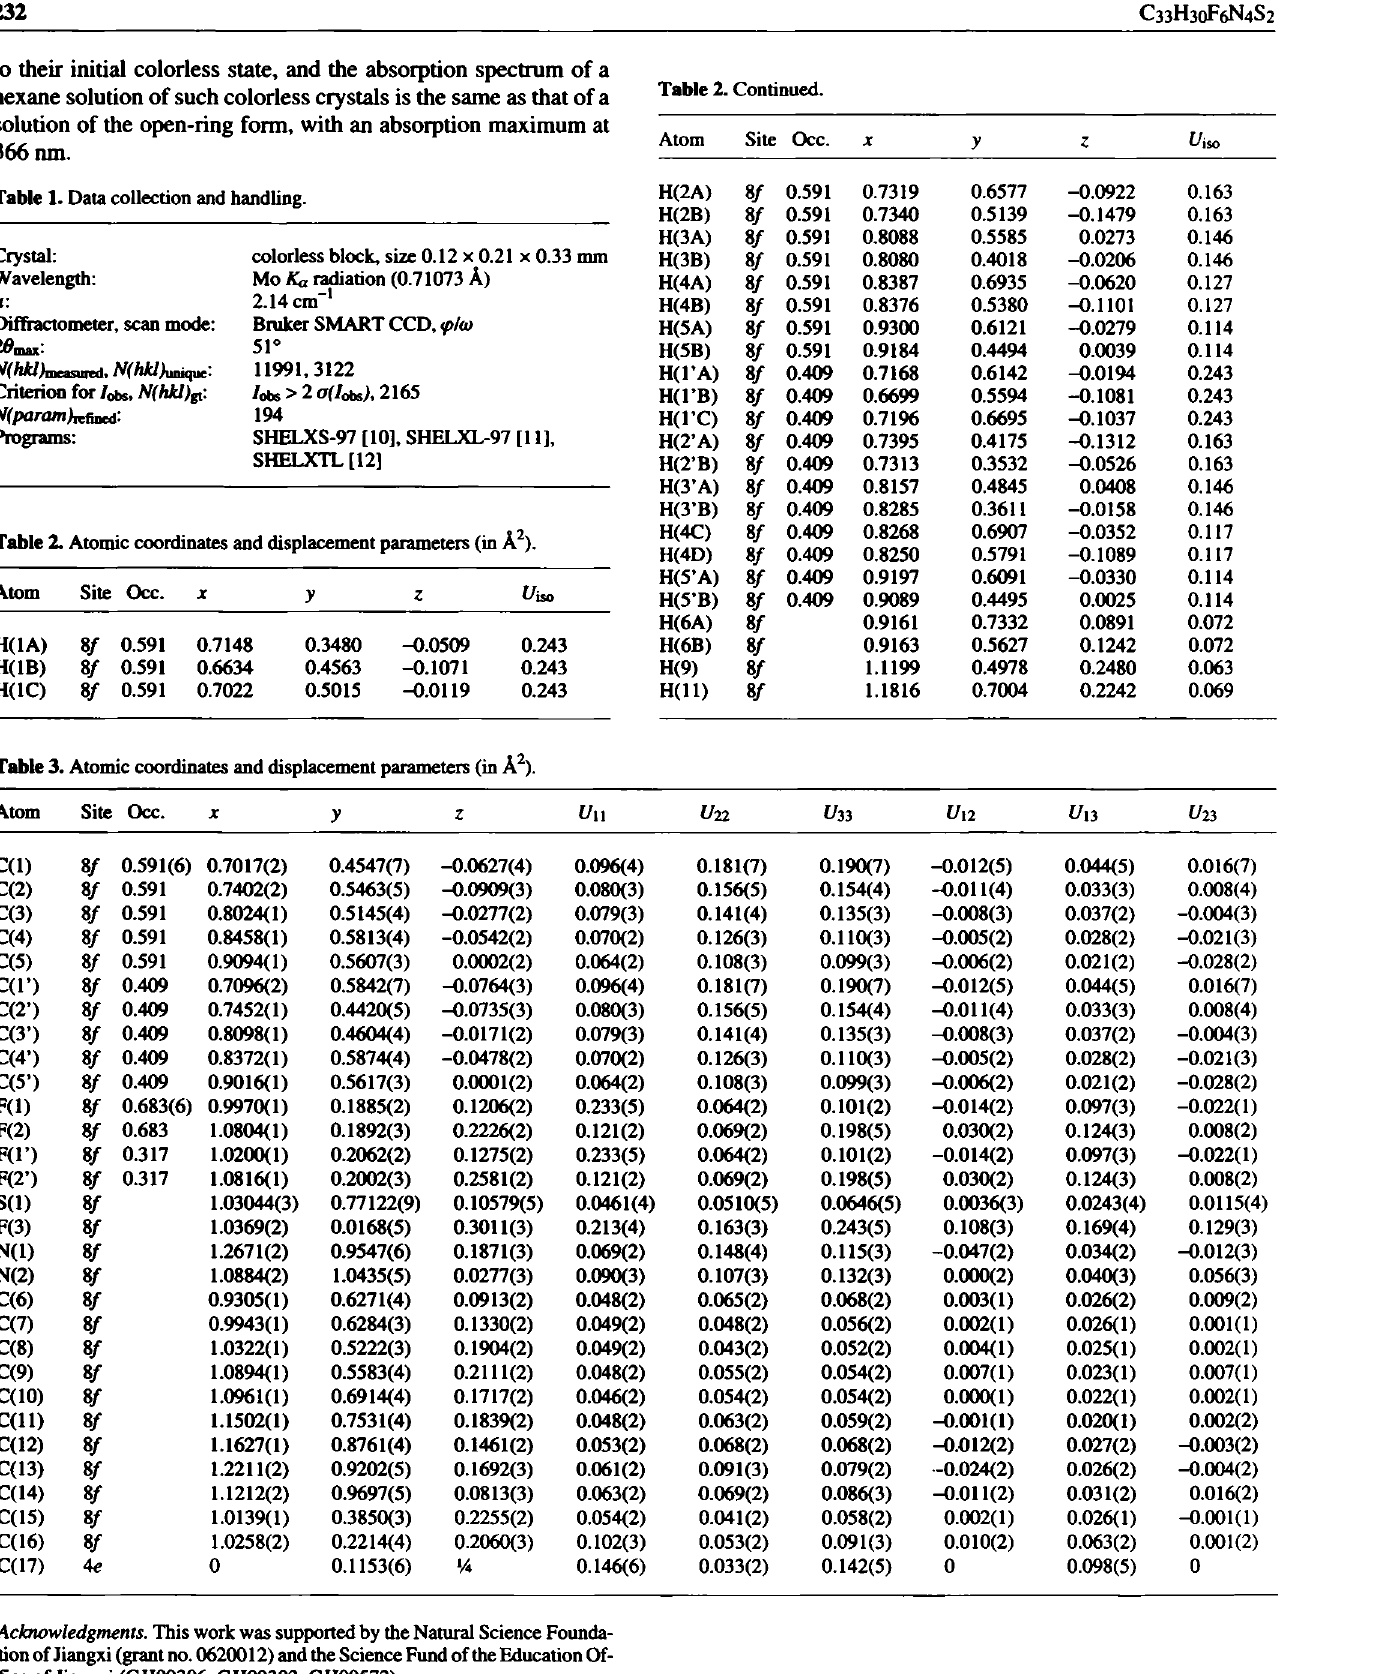
Table 2. Atomic coordinates and displacement parameters (in Â 2 ).